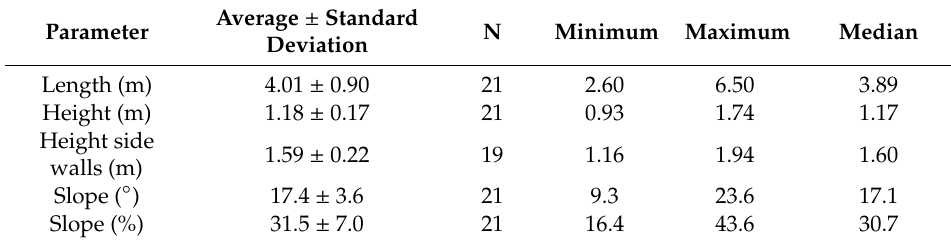
Table 1. Dimensions and slope of the loading docks in the 18 collection points in degrees and in